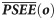

PSEE¯(o), PSEE¯(d) and t(PSEE) for different contact radius (CR) values.Mean PSEE for ordered and disordered residues, indicated by green line with circle marker and red line with diamond marker respectively, of DisProt680 dataset for CR values of 4 to 30. The separation line or, threshold (t(PSEE)) is drawn with a black dashed line. The x-axis and y-axis show the CR and mean PSEE values, respectively.